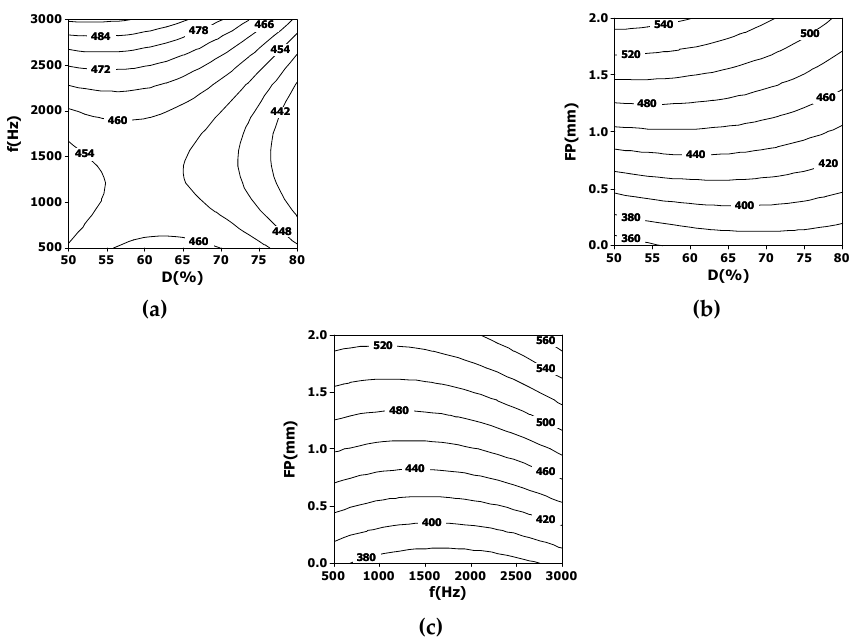
Figure 3. Contour plots showing the interdependence of some laser processing parameters, namely: ( a ) duty cycle and frequency; ( b ) duty cycle and focus position; ( c ) focus position and frequency, on the average entrance diameter (in microns).